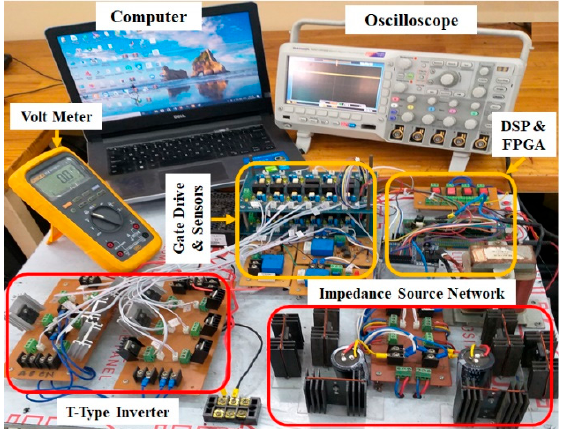
Figure 10. A photo of the hardware setup.